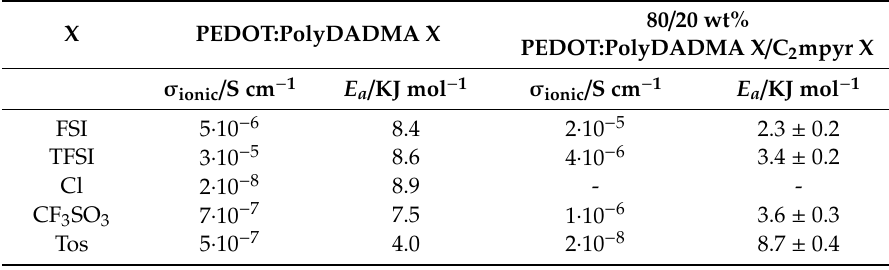
Table 4. Ionic conductivity values and E a of PEDOT:PolyDADMA X and 80 / 20 wt% composites at 50 ◦ C.